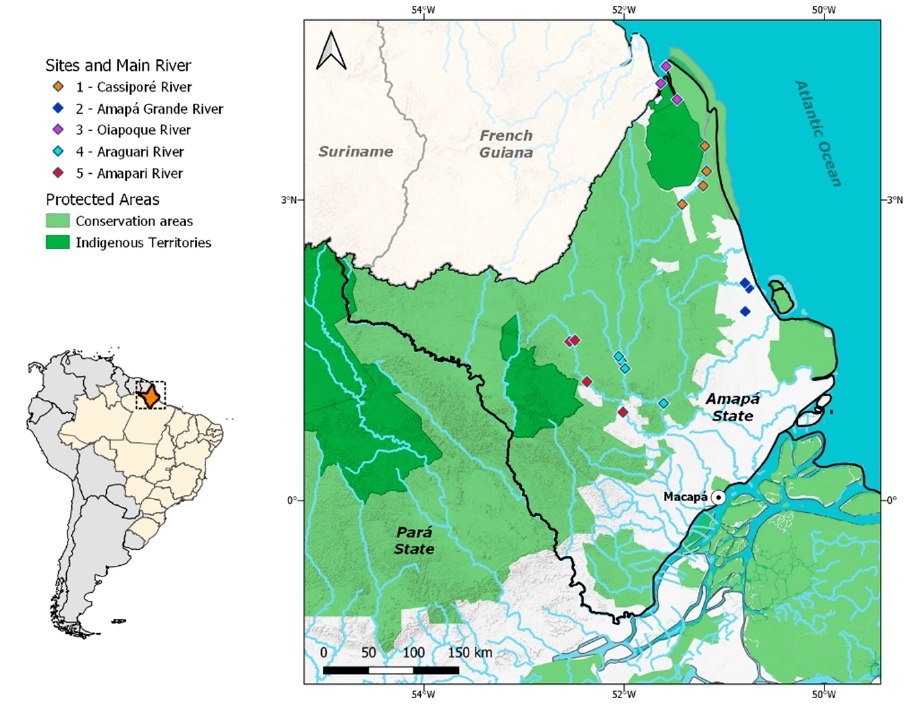
Figure 1. Map of the study area indicating the sampling sites, protected areas, and indigenous territories.